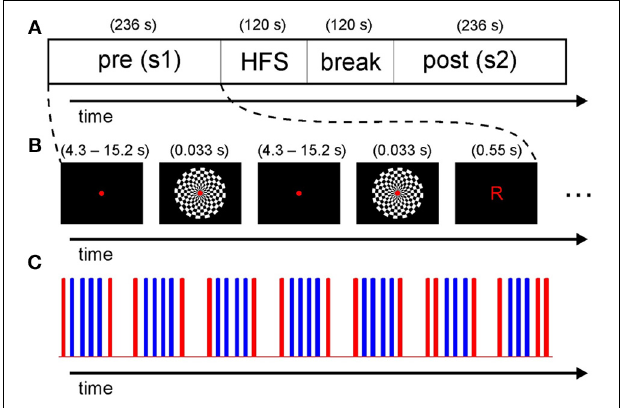
FIGURE 1 | Timing of the overall experiment. (A) Subjects were presented with a pre-HFS session of checkerboard flashes and catch trials, followed by a high frequency stimulation (HFS) block and a 2min break before the post-HFS session. (B) Timing of the individual stimuli. The subjects were required to fixate a red dot. Checkerboards and letters were presented at varying rates for optimal design efficiency. (C) The timing of all stimuli in one session is represented as a stick function. The checkerboard flashes are displayed in blue and the letters in red (see text for details on